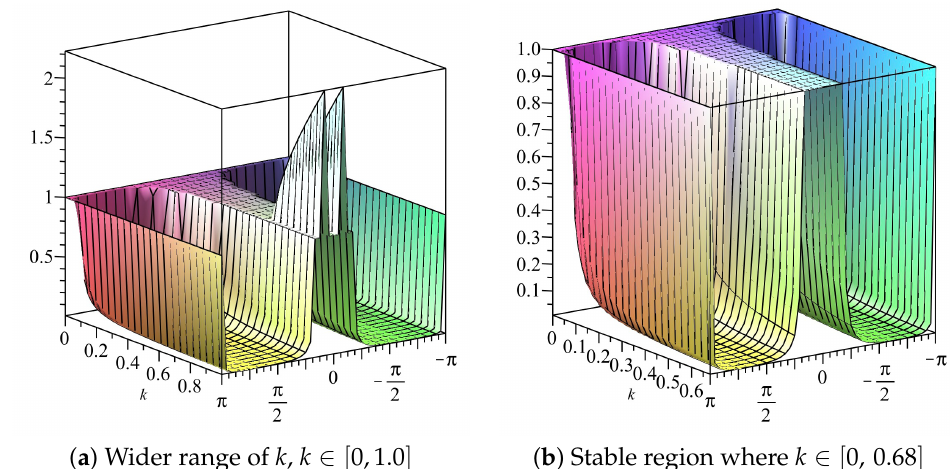
Figure 11. Plot of | ξ 1 | vs. k vs. w ∈ [ − π , π ] of Scheme 3 for Numerical Experiment 1. The spatial step size h = π /10.